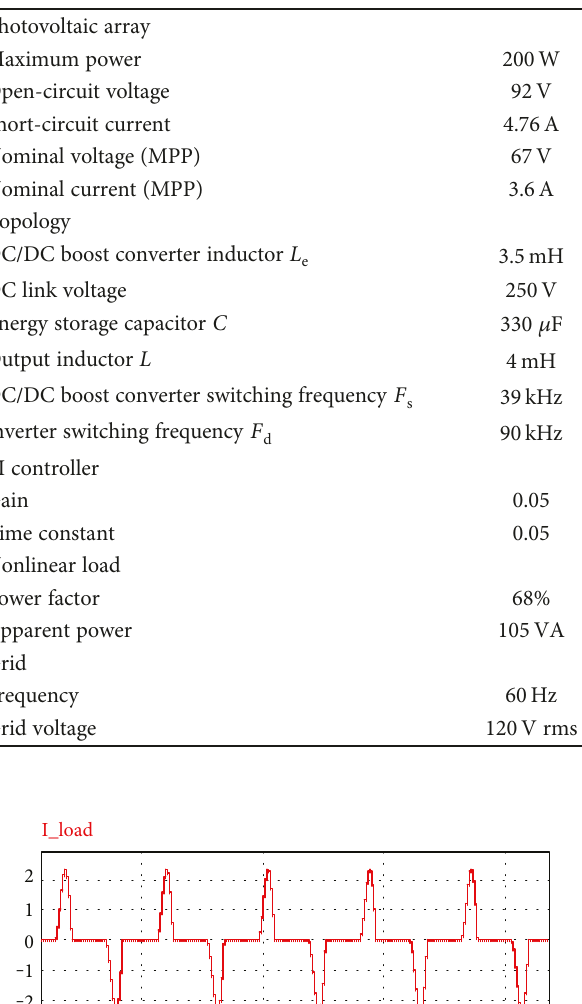
Table 1: Simulation and experimental parameters.